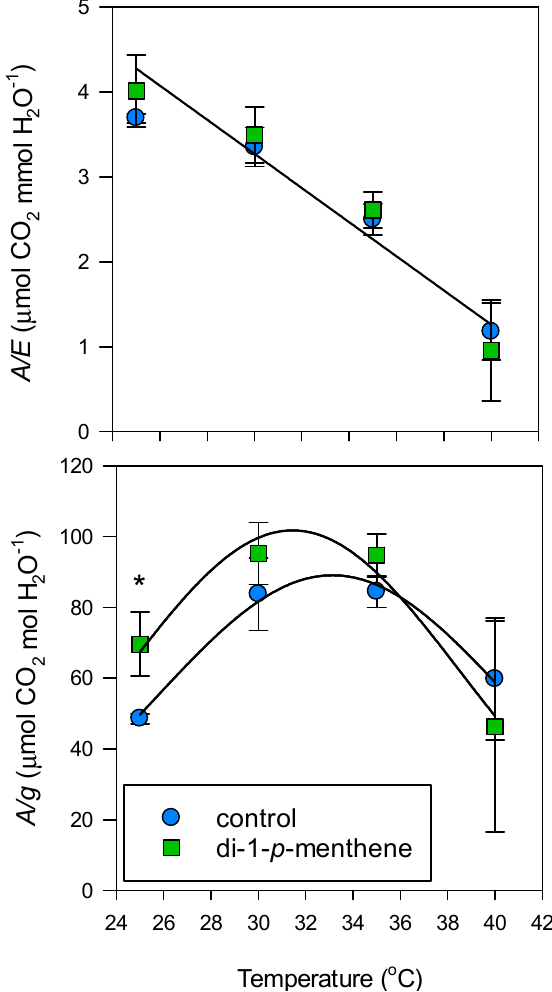
Figure 4. “Tulameen” raspberry instantaneous transpiration efficiency ( A/E ) and intrinsic transpiration efficiency (A/ g ) in response to temperature following treatment with 1% di-1- p -menthene. Control leaves were treated with dH 2 O only. Leaf gas exchange was monitored 48 h after application. The light intensity of the IRGA leaf chamber was set to 1500 μ mol m − 2 s − 1 , and the block temperature was increased at 5 °C intervals from 25 to 40 °C. Data are expressed as means ± s.e.m., n = 5, * p < 0.05. Di-1- p -menthene was effective at reducing fruit transpiration by 25% prior to the onset of ripening (Figure 5). However, with the onset of anthocyanin production and chlorophyll degradation, fruit at